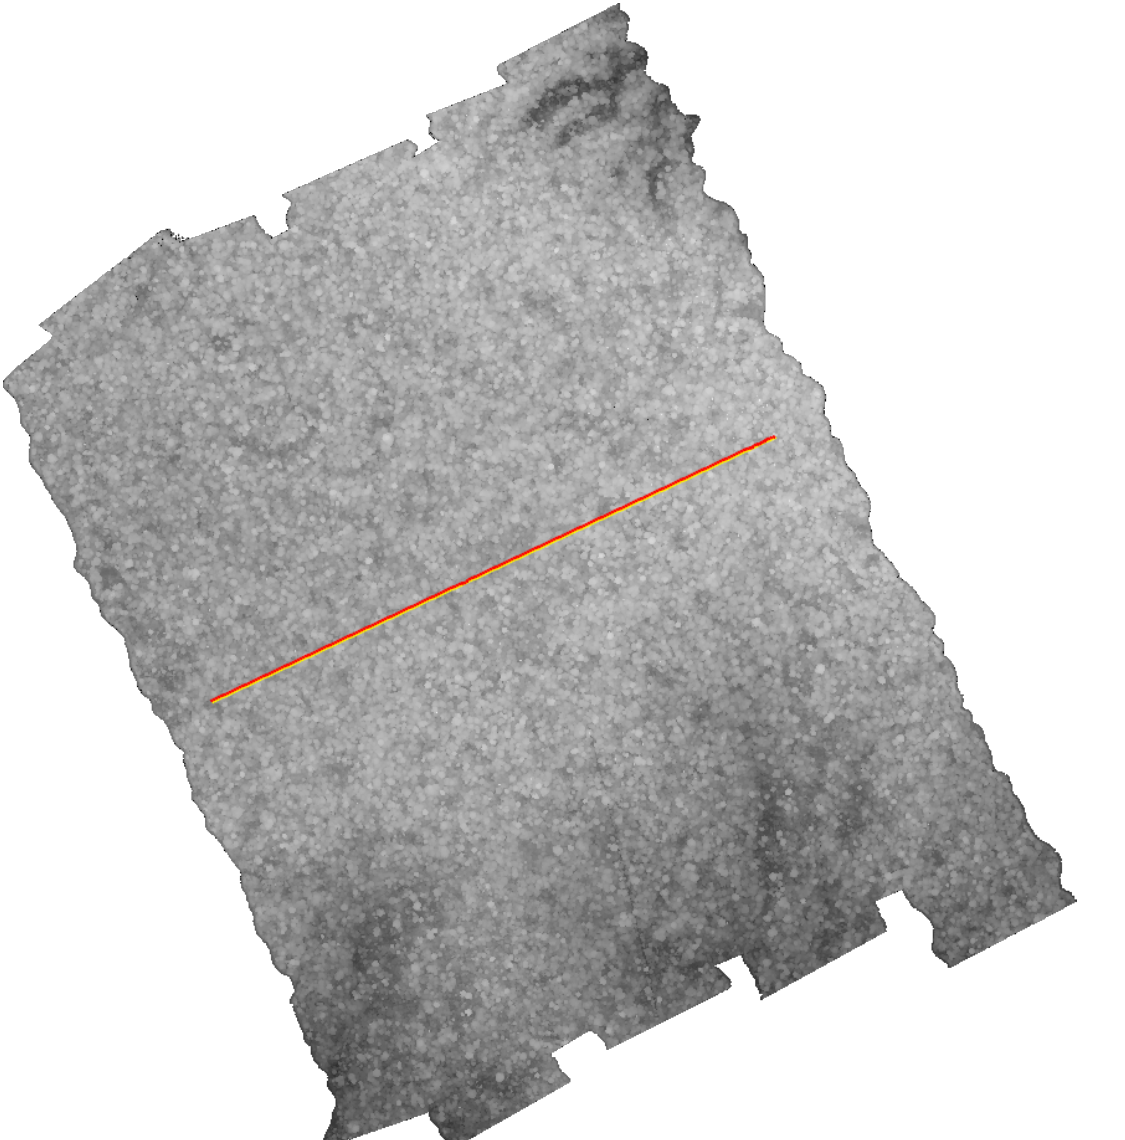
Figure 23. Trajectory in yellow on filtered surface, circular bin, experiment. Corresponding estimated positions are drawn in